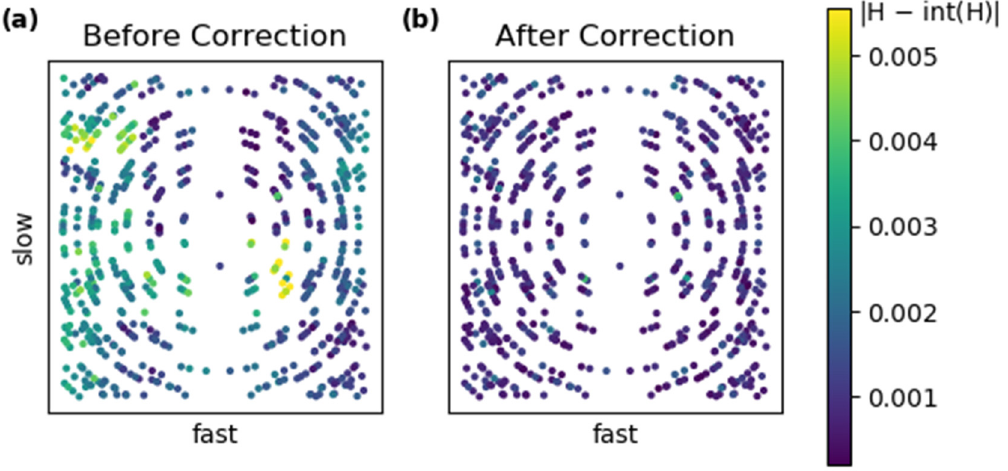
Figure 4. Plots of the deviations of spot positions from integer ( h,k,l ) for the silicon single crystal as a function of position on the detector face. ( a ) Data prior to the spatial correction derived from the powder data. ( b ) The same data after the correction derived from the powder data was applied.